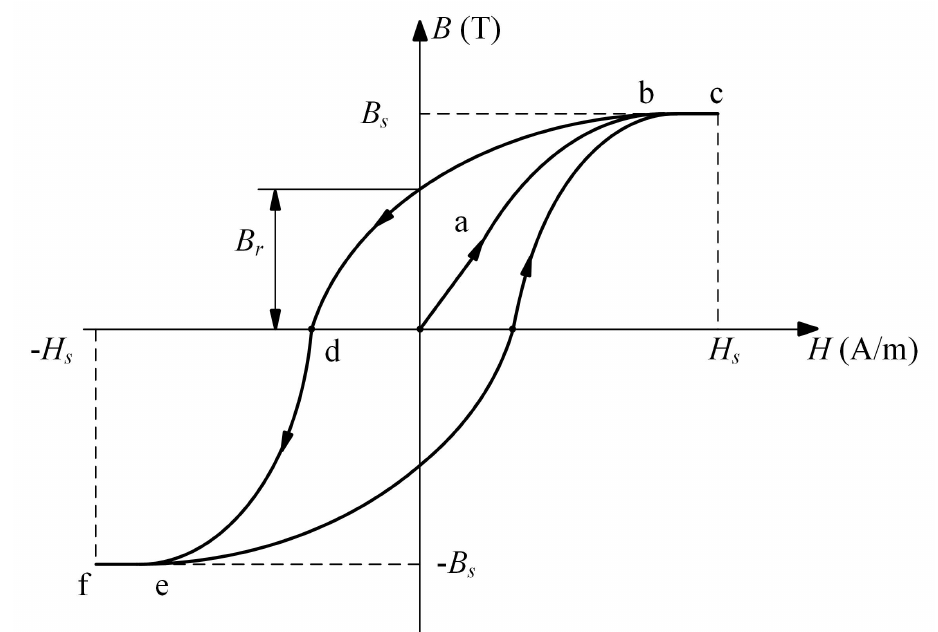
Figure 1. Hysteresis Loop of Ferromagnetic